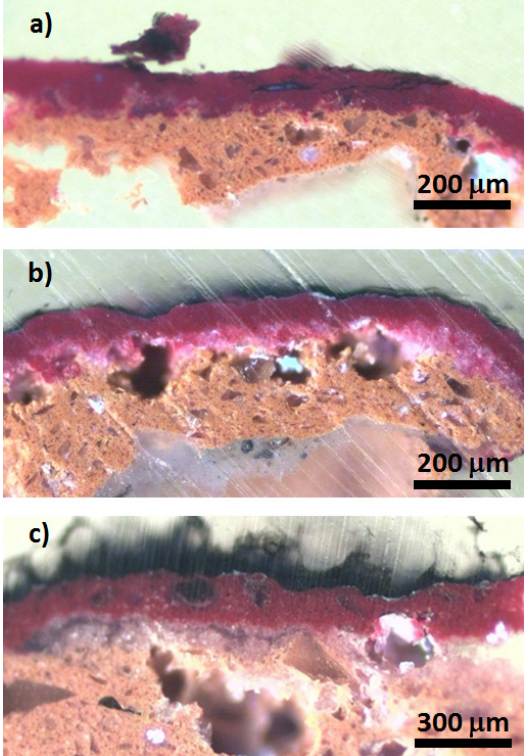
Figure 2. Microscopy images of: ( a ) MTN94 paint—vandal layer; ( b ) MTN94 paint—KEIM coating—vandal layer; ( c ) IVAS SP paint—RO-ART coating—vandal layer.